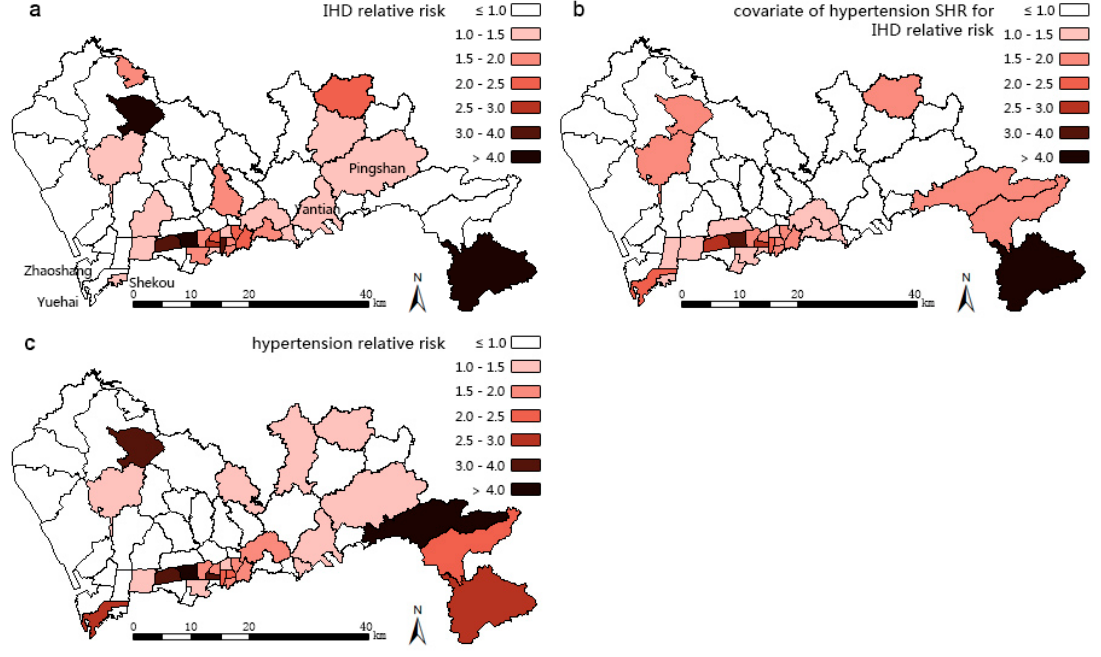
Figure 5. Results obtained using Model 2. Spatial patterns of posterior estimates of ( a ) overall IHD relative risk (RR); ( b ) RR of IHD explained by hypertension; ( c ) overall hypertension RR.